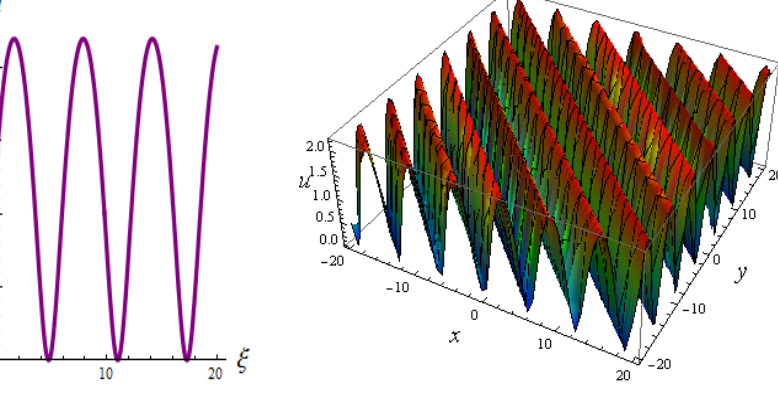
Figure 6: (a) 2D plot for u 11 . (b) 3D plot for u 11 ( x , y ) , when t = 0 .